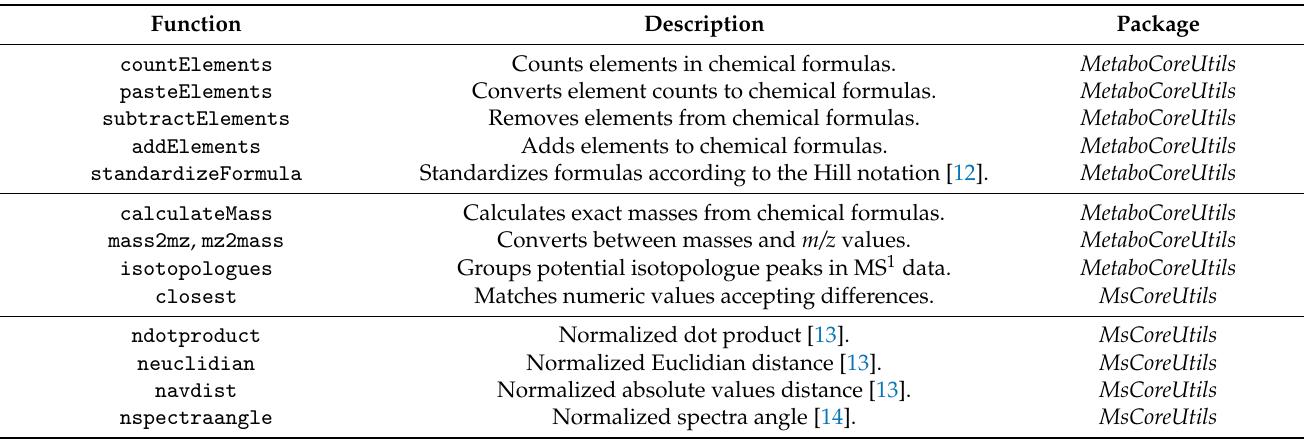
Table 1. Listing of core utility functions for metabolite annotation. The first panel contains functions to work with chemical formulas followed by a panel with various utility functions. The last panel contains functions to calculate established spectra similarity